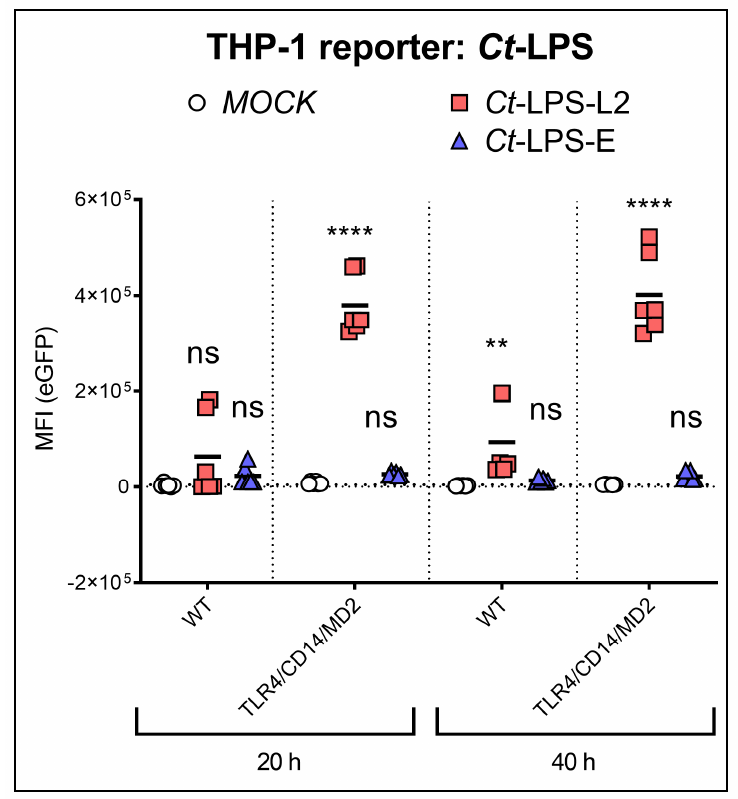
Figure 2. NF- κ B induced expression of eGFP upon recognition of Ct-LPS (500 ng/mL) derived from serovar L2 or -E. The experiments were performed after 20 h or 40 h of incubation with WT- or TLR4/CD14/MD2 THP-1 reporter cells. The data represent eGFP-MFI means ± SEM of three independent experiments. Statistical differences between WT (20 h) and individual conditions were assessed by 2way ANOVA followed by Dunnett’s multiple comparisons test for each serovar. ** P < 0.01, **** P < 0.0001; ns, not significant. Individual measurements are shown (n = 6), each experiment was performed in duplicates.